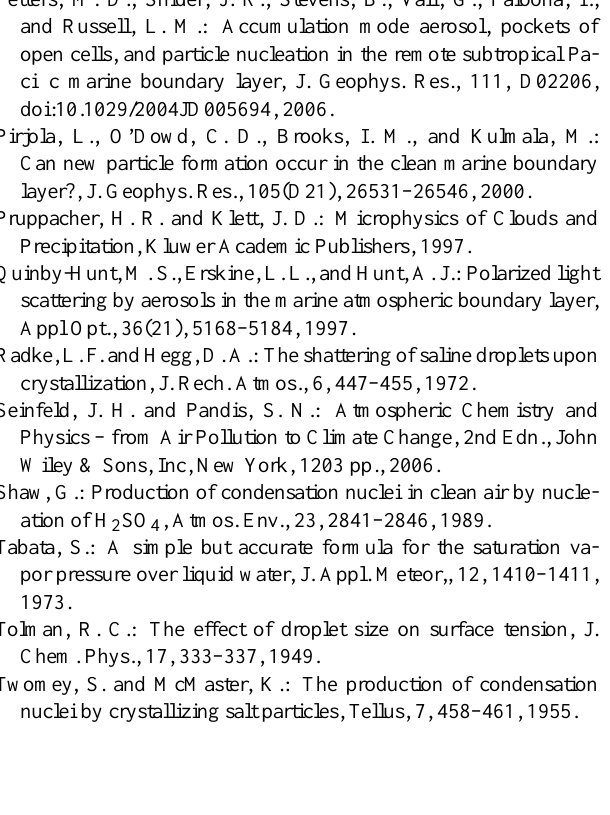
Tabata, S.: A simple but accurate formula for the saturation va- por pressure over liquid water, J. Appl. Meteor,, 12,